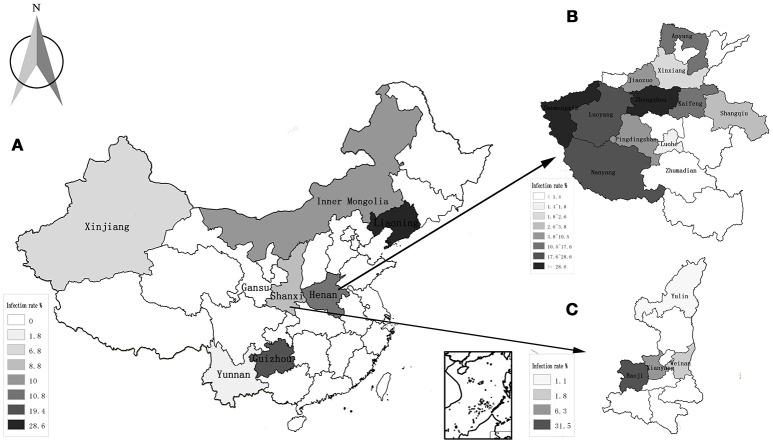
Distribution and infection of A. capra in all the studied regions. (A) The average rate of infection in 8 provinces of China; (B) the rate of infection in 12 countries of Henan province; (C) the rate of infection in 4 countries of Shanxi province.